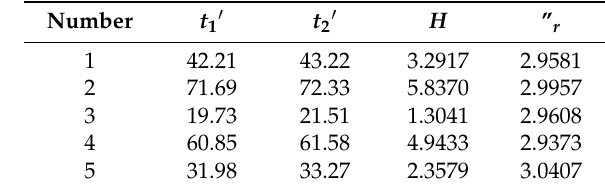
Table 3. Estimated parameters of the simple experiment model.